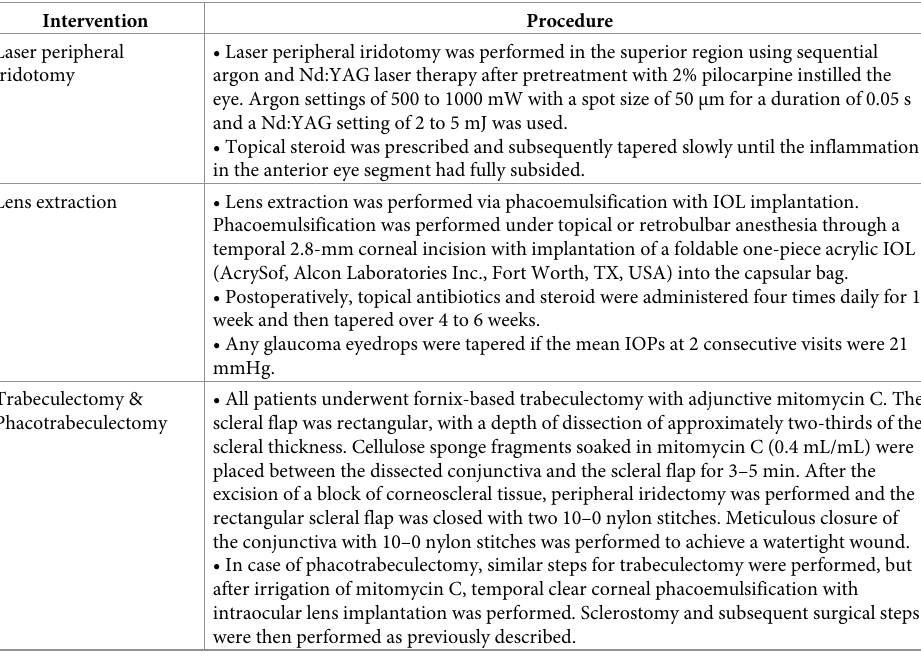
Table 1. Interventions for management of acute primary angle closure in this